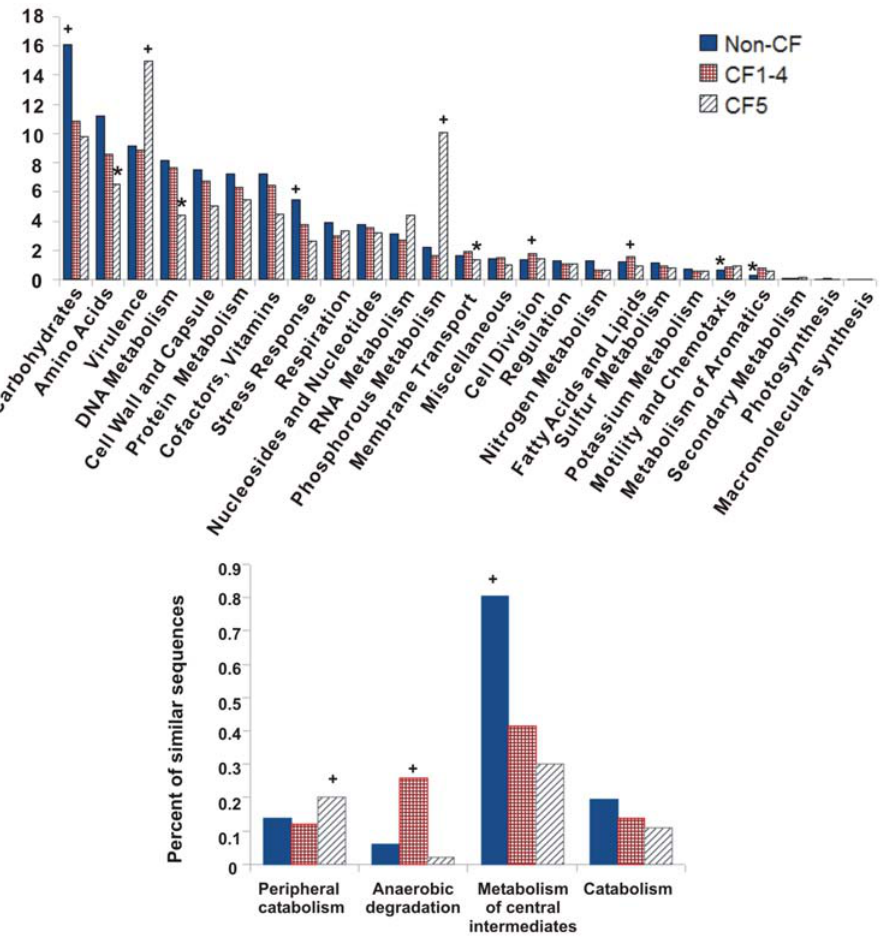
Figure 7. Distribution of similarities to metabolic subsystems in respiratory viromes. (A) Distribution of top-level subsystems in respiratory tract viromes. (B) Second-level subsystems from the SEED hierarchy for aromatic metabolism. Non-CF viromes are shown in blue, CF viromes 1–4 are shown in red, and CF5 is in gray. Subsystems determined by XIPE to be over-represented in a particular group are marked with a ( + ) while those that are under-represented are marked with an asterisk